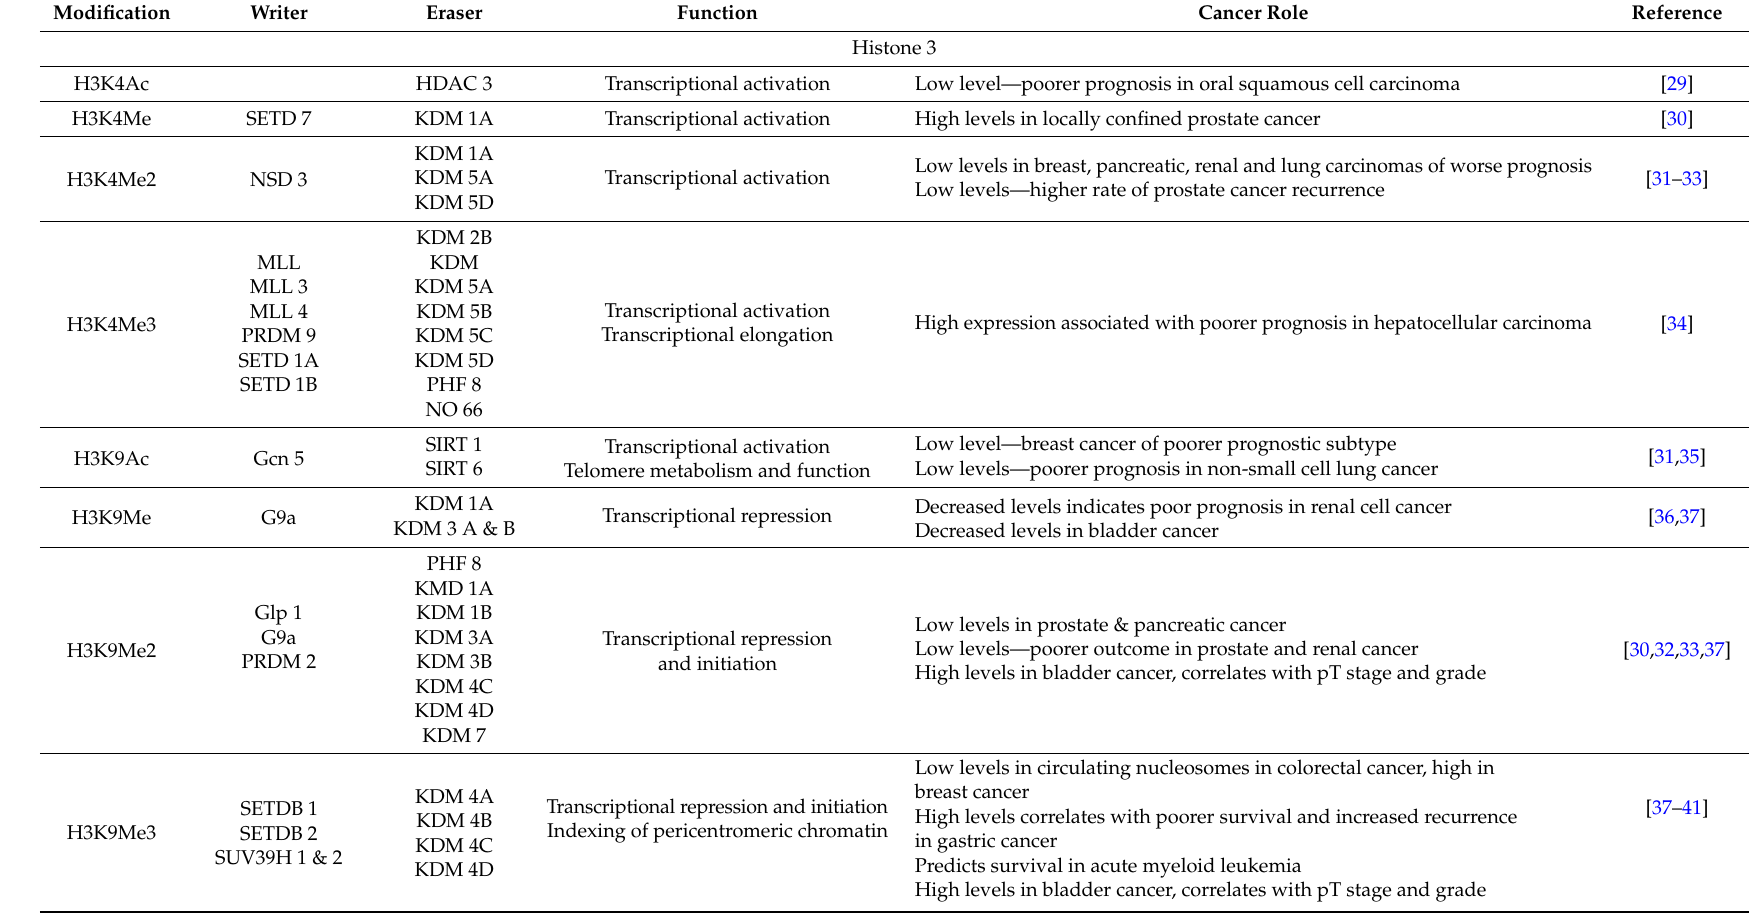
Table 2. Histone 3: PTM quantification as cancer